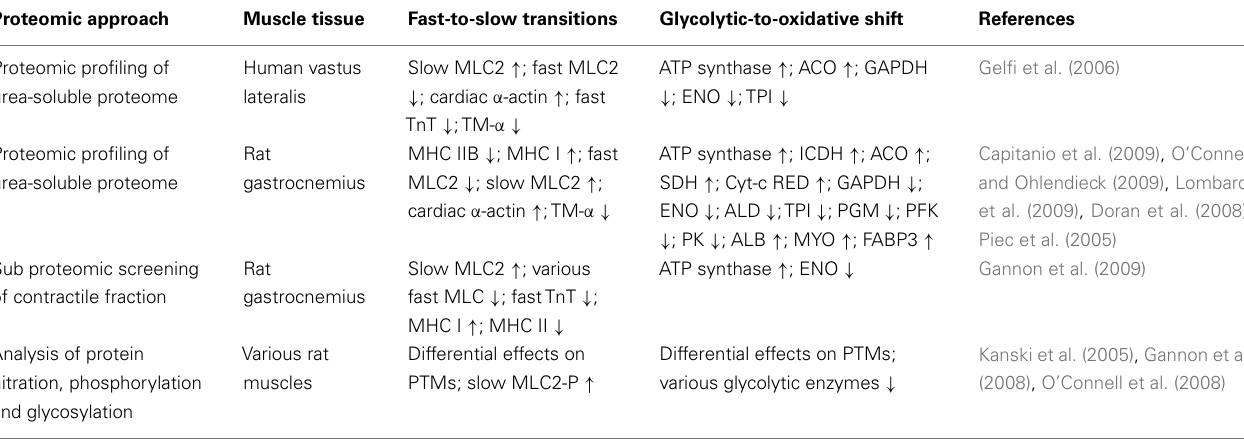
Table 1 | Major trends in protein changes during skeletal muscle aging as revealed by mass spectrometry-based